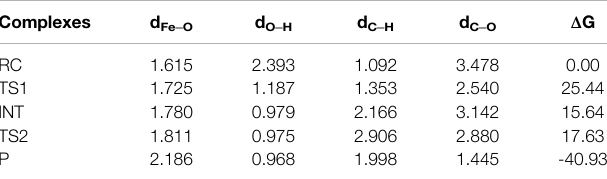
TABLE 2 | Selected Bond Lengths (Å) and the relative electronic energies ( Δ G, kcal · mol − 1 ) of species involved in the reaction of CH 4 oxidation catalyzed for the quartet of